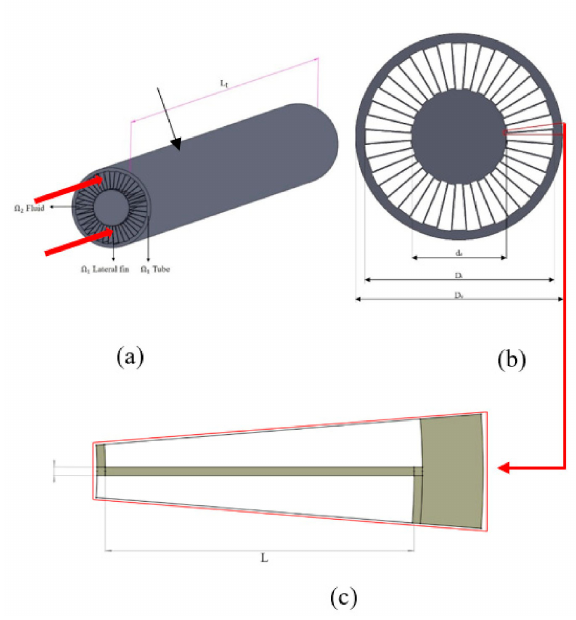
Figure 1. The physical model of PTHE-Z. ( a ) three-dimensional view, ( b ) cross-sectional view and ( c ) computational